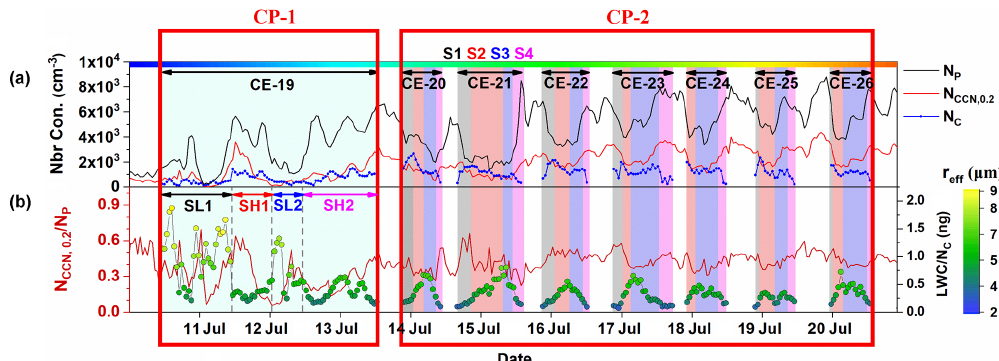
Figure 3. Variation of (a) N C , N p , and N CCN,0.2 and (b) N CCN,0.2 /N P and LWC /N C during CP-1 and CP-2.